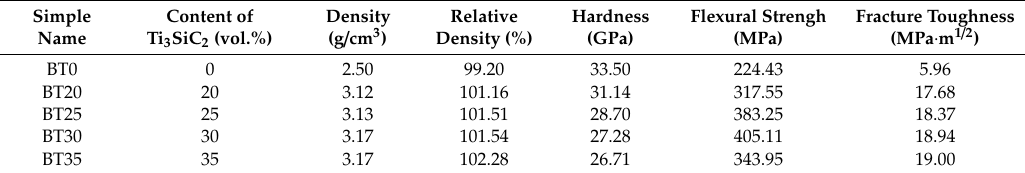
Table 2. Properties of ceramics prepared with di ff erent contents of additive Ti 3 SiC 2 .